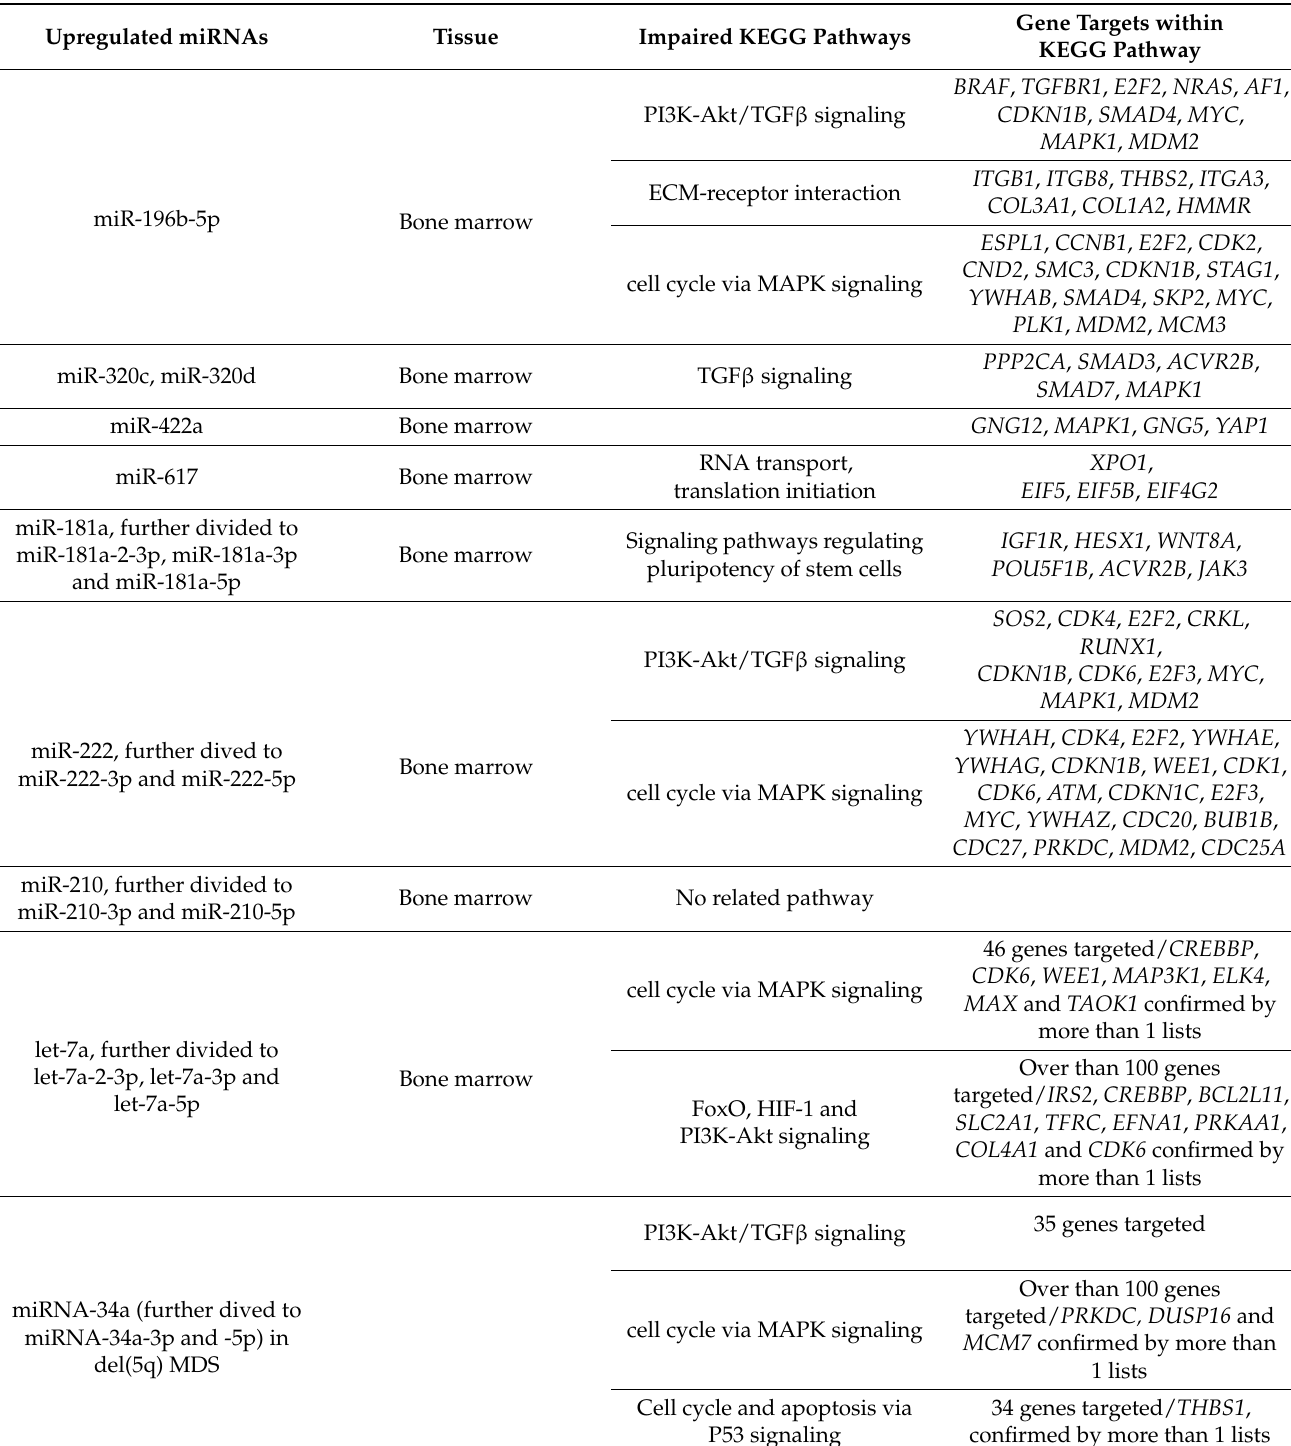
Table 1. Up- and down-regulated miRNAs in MDS, related KEGG pathways and targeted human genes. Data were extracted via mirPath v.3 tool provided by DIANATOOLS (https://dianalab.e-ce.